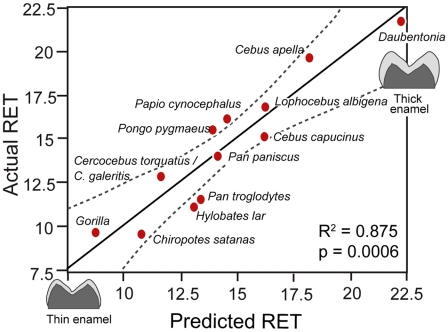
Predicted versus actual values of relative enamel thickness (RET) based on the raw data for three dietary variables.